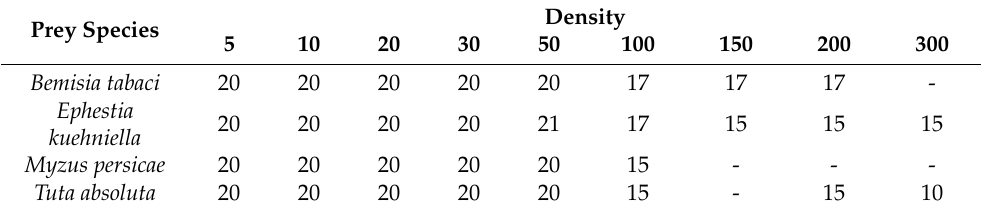
Table 1. Number of replicates for each prey density offered to Dicyphus cerastii females. Prey